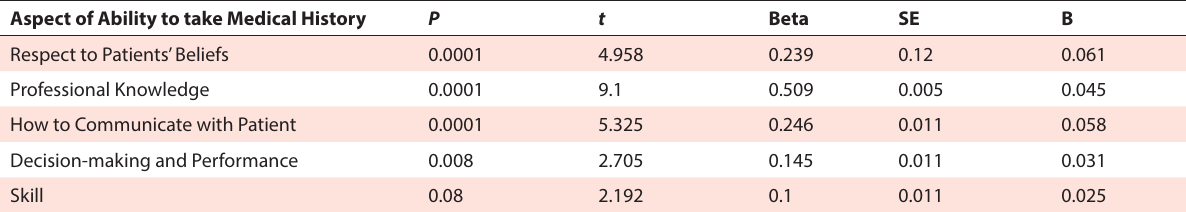
Table 3. Results of anticipating each aspect of taking medical history on the ability to take medical history of patients in medical emergency in Golestan province EMS, in 2015 a Aspect of Ability to take Medical History P t Beta SE B Respect to Patients’